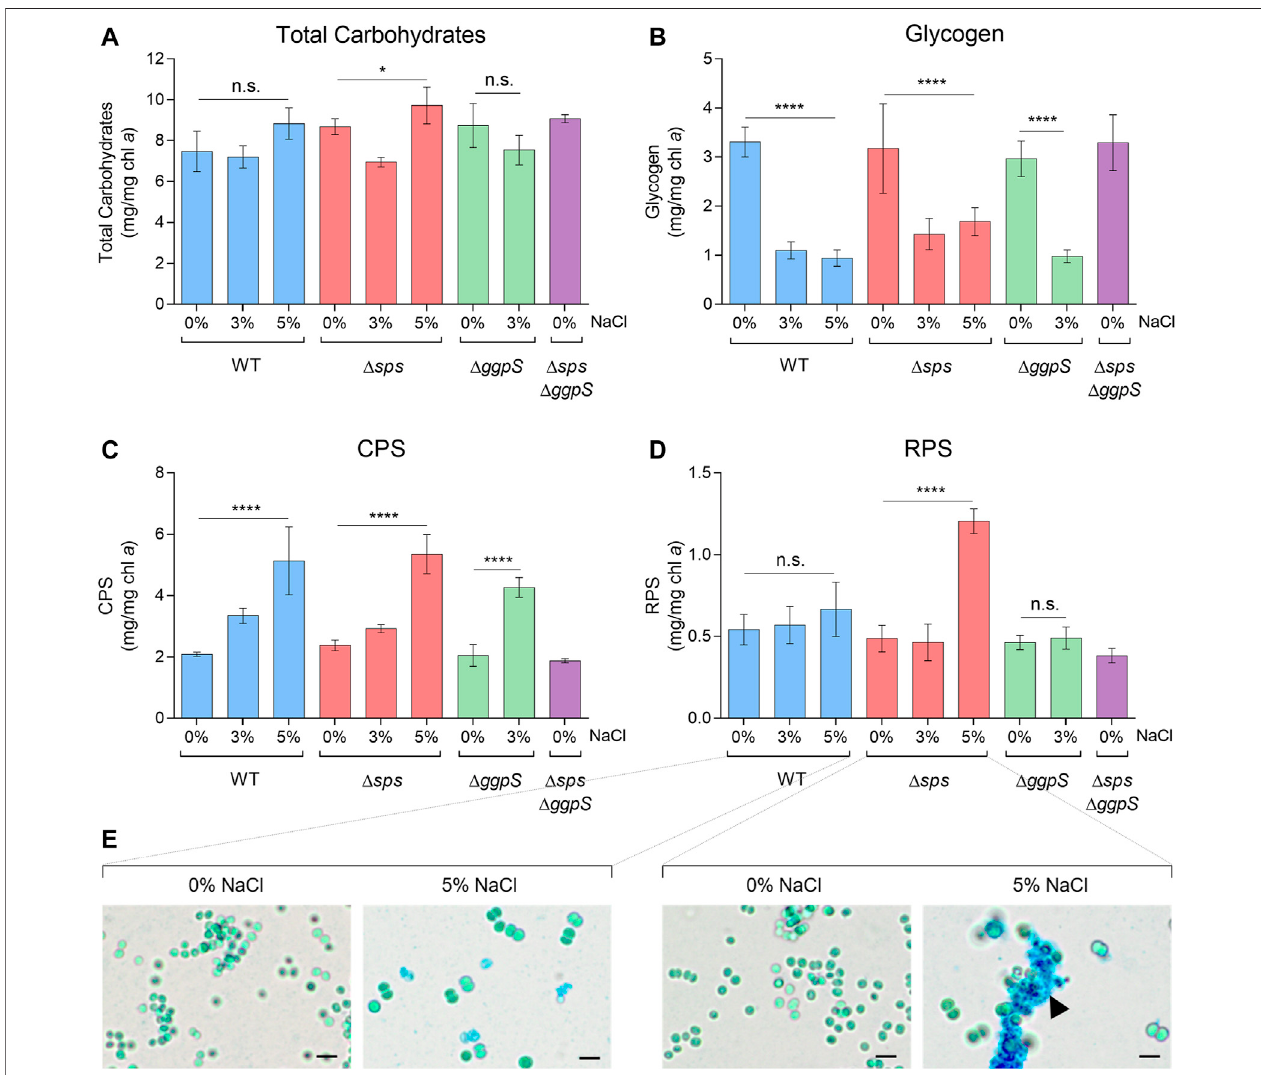
FIGURE 3 | Effect of NaCl on total carbohydrates (A) , glycogen (B) , CPS — capsular polysaccharides (C) , and RPS — released polysaccharides (D) produced by Synechocystis wild-type (WT) and the Δ sps , Δ ggpS , and Δ sps Δ ggpS mutants. Cells were grown in BG11 or BG11 supplemented with 3% or 5% (wt/vol) NaCl, at 30 ° C with orbital shaking (150 rpm) under a 12 h light (25 μ E/m 2 /s)/12 h dark regimen for 16 days. Results are expressed as milligrams per milligram of chlorophyll a (chl a ). Error bars correspond to standard deviations from at least three biological replicates, with technical triplicates. Statistical analysis was performed using one-way ANOVA. Statistically signi fi cant differences are identi fi ed: **** ( p ≤ 0.0001), * ( p ≤ 0.05), and n.s. (not signi fi cant). Light micrographs (E) of Synechocystis WT and Δ sps cultures grown in BG11 or BG11 supplemented with 5% NaCl and stained with Alcian Blue; the black arrowhead highlights RPS production by the Δ sps mutant under 5% NaCl. Scale bars: 5